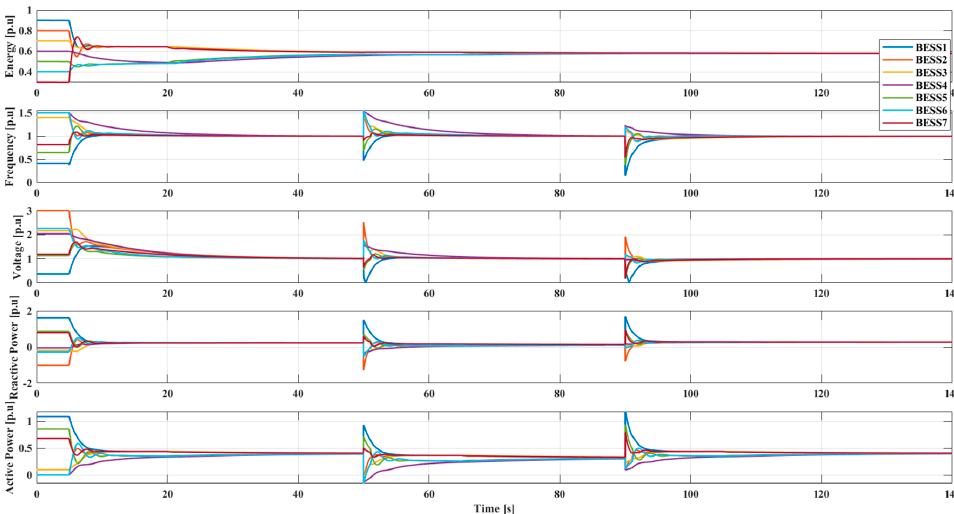
Figure 9. Simulation results of the consensus algorithm with communication delay (case 5).